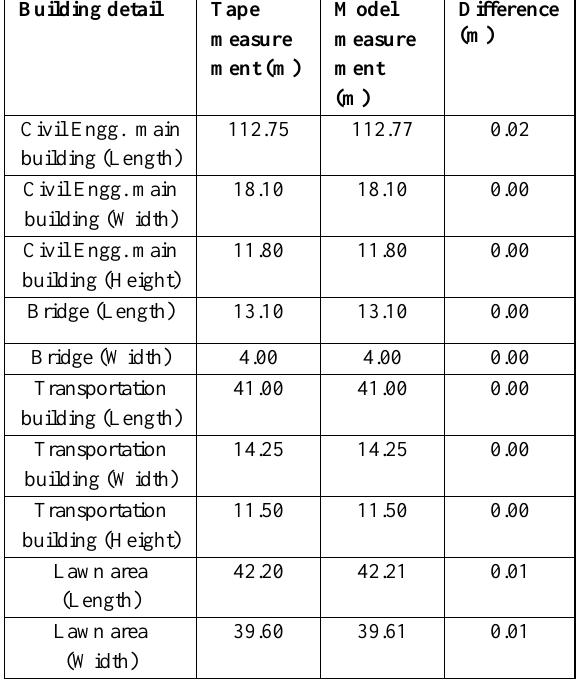
Table 1: Accuracy result analysis for 3D